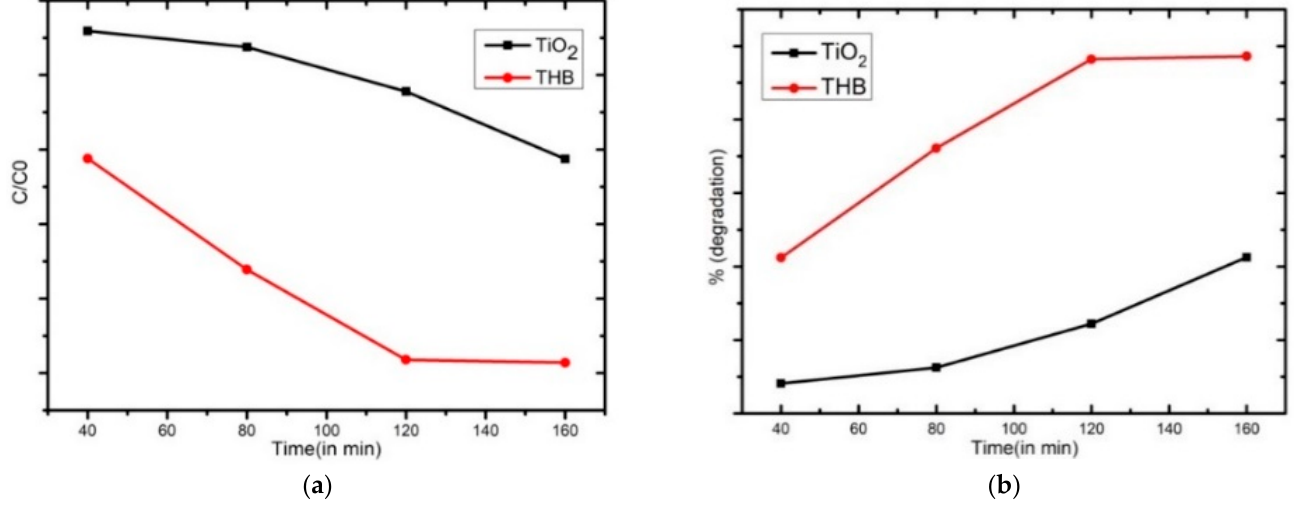
Figure 6. ( a ) Degradation profile for 10 ppm caffeine using TiO 2 and THB catalyst. ( b ) Degradation efficiency of TiO 2 vs. THB photocatalyst to degrade 10 ppm caffeine solution.